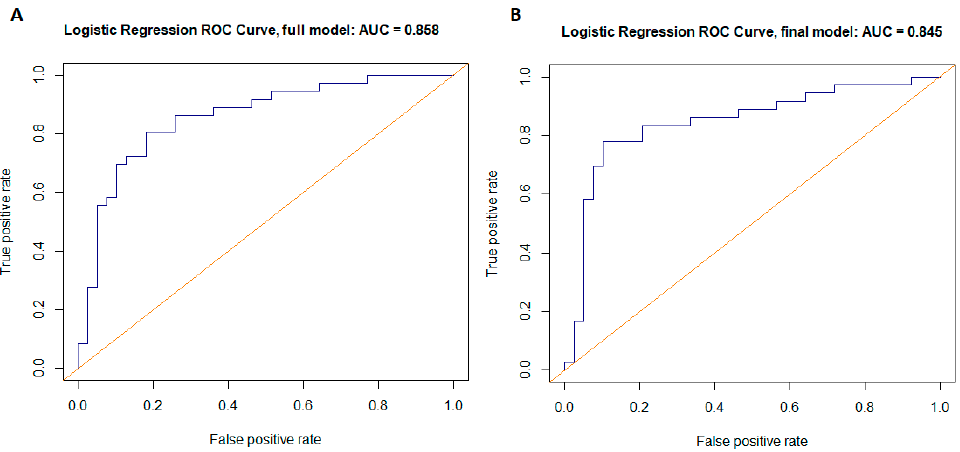
Figure 5. Visualization of ROC curves representing two logistic regression models: ( A ) full model (all explanatory variables, i.e., all CpG dinucleotides included) and ( B ) final model obtained by stepwise approach (AIC) including only selected CpG dinucleotides.